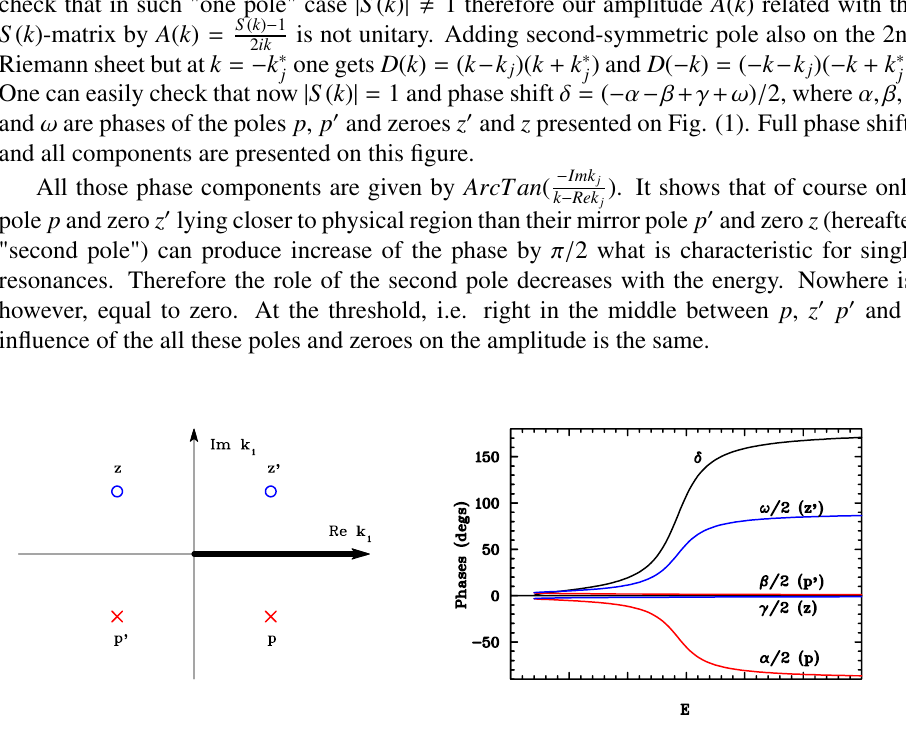
Figure 1. Schematic positions of all necessary poles and zeroes of an unitary amplitude for single res- onance in the complex momentum plane (left figure) and phases of all these poles and zeroes compared with their sum δ - phase shifts of the amplitude (right figure), thick black line denotes physical